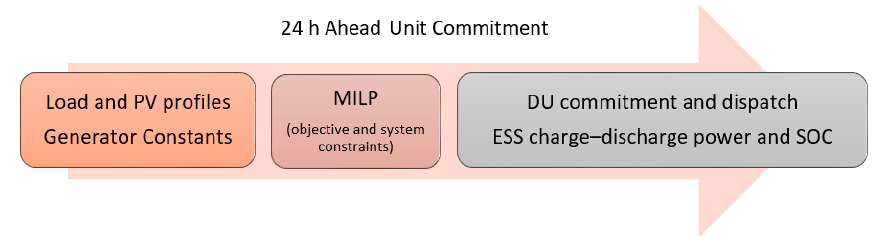
Figure 1. The architecture of the research.